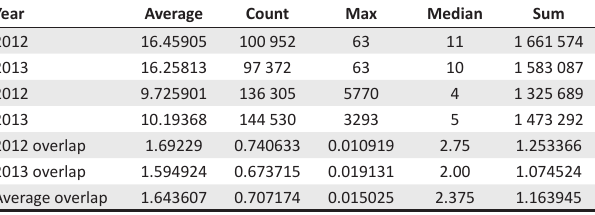
TABLE 1: Overlap between the two data sources in 2012 and